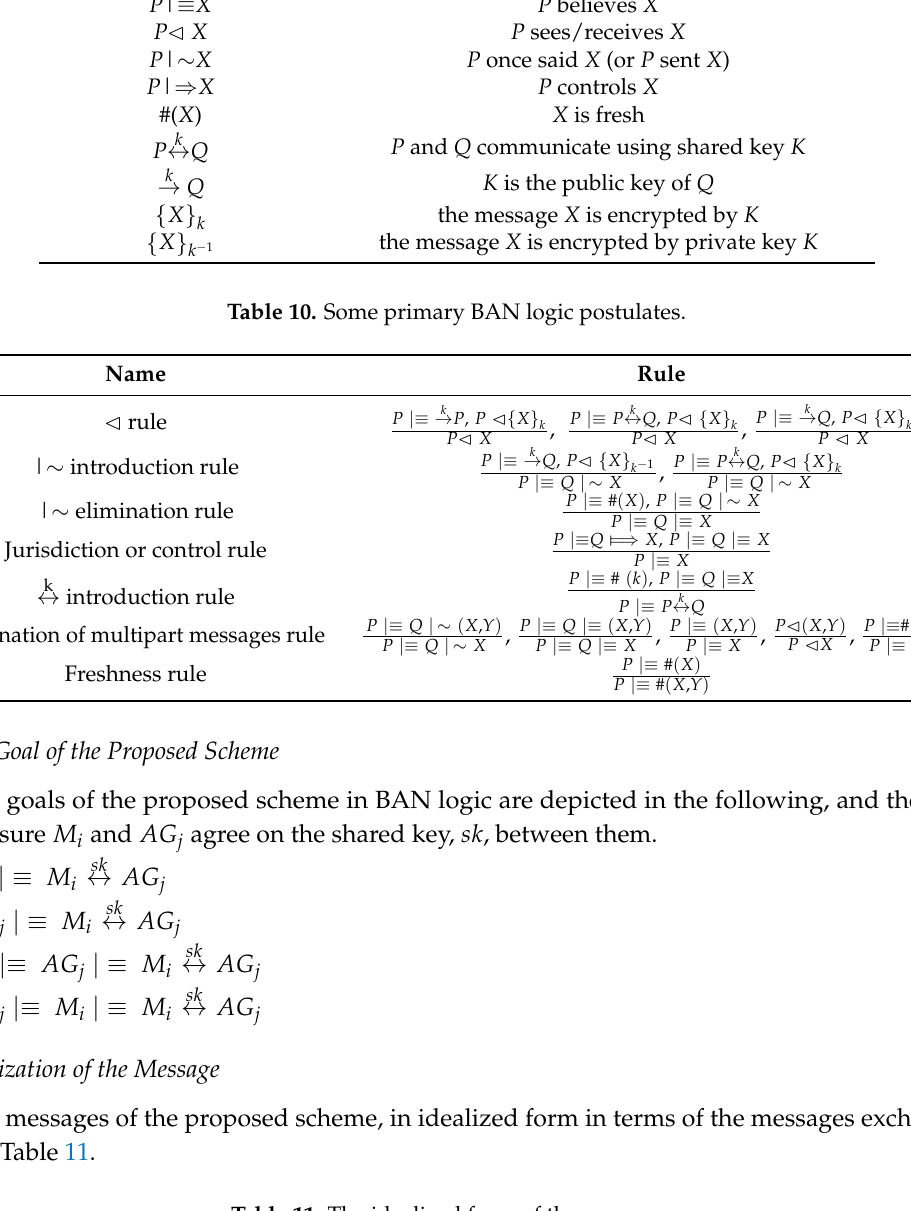
Table 11. The idealized form of the